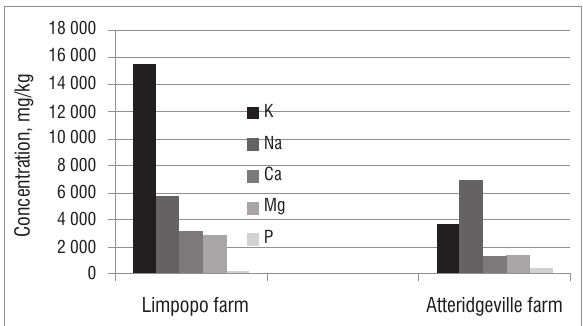
Figure 3: Average concentration of major nutrients in soil samples from farms in the Limpopo and Atteridgeville. Results shown are means of triplicates; errors bars (%RSD) are omitted because they do not add value at this scale.